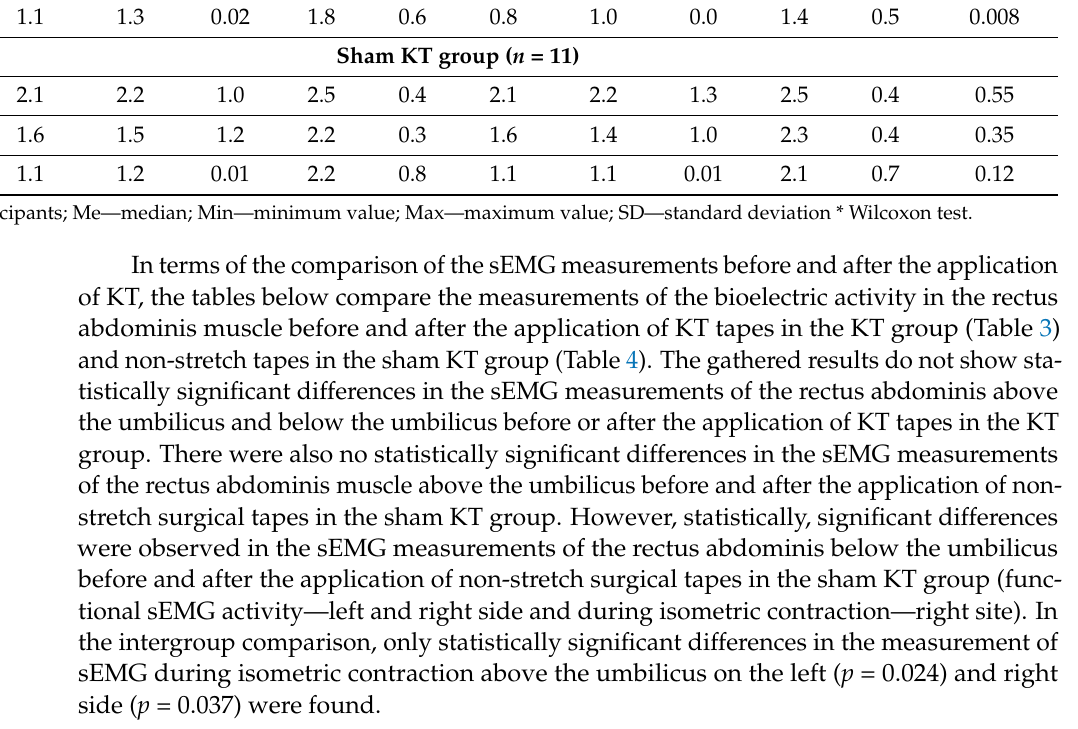
In terms of the effects of KT on rectus abdominis diastasis, the gathered results show a statistically significant reduction in rectus abdominis diastasis at each of the observed sites after the application of KT tapes in the intervention group ( p < 0.05) (Table 2). In the control group, no statistically significant differences were found at any of the studied sites before or after the application of non-stretch tapes ( p > 0.05) (Table 2). In the intergroup comparison, a statistically significantly lower RAD (at umbilicus) was found after the intervention ( p = 0.005) in KT group. Table 2. The comparison of RAD before and after intervention in both groups. Before After Mean